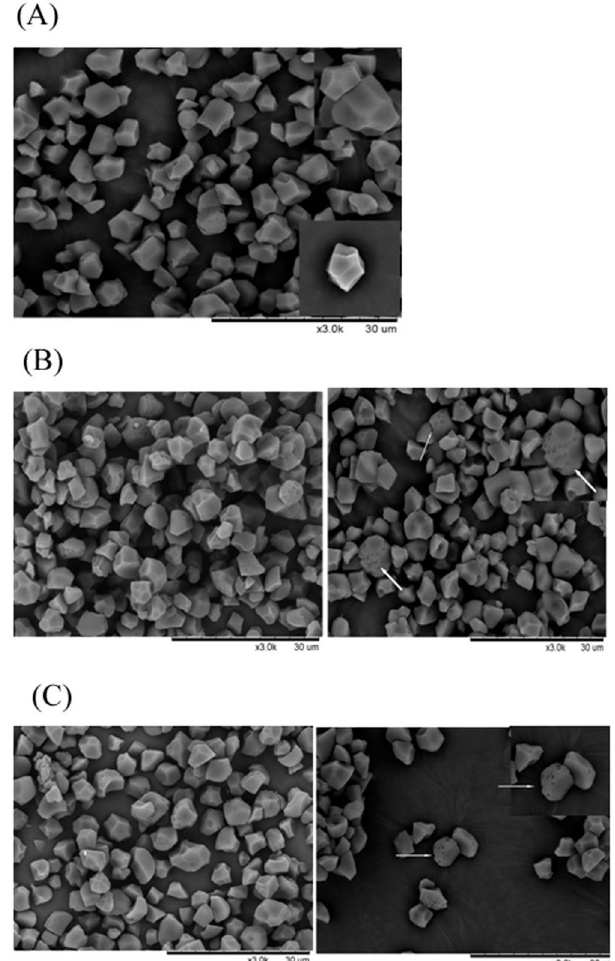
Figure 3. Starch granules visualized by Scanning Electron Microscopy at 3000 × . ( A ) Control (Zhonghua 11). ( B ) RGD3. ( C ) RGD5. White arrows indicate pores in the starch granule. Selected starch granules in central part are magnified at 5000 × and shown at the lower -right ( A ) and upper-right corners ( B and C ).